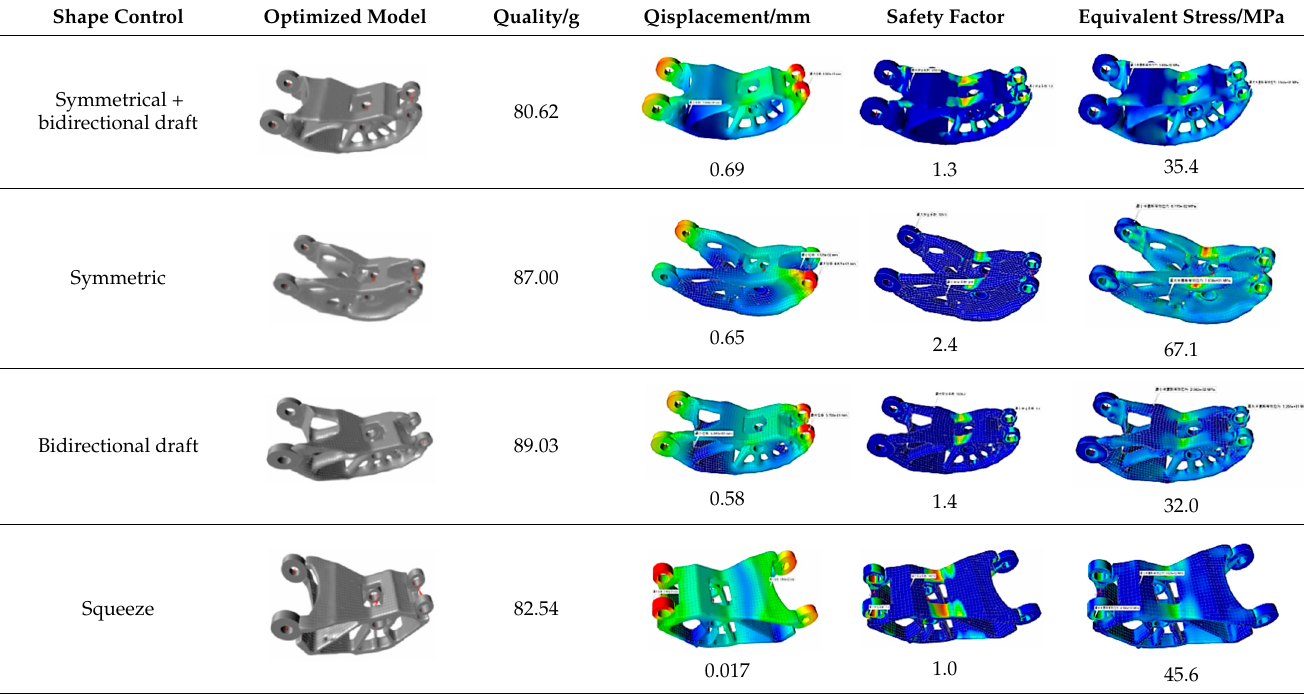
Table 1. Strength analysis results of shock-absorbing-bearing parts under different shape controls.